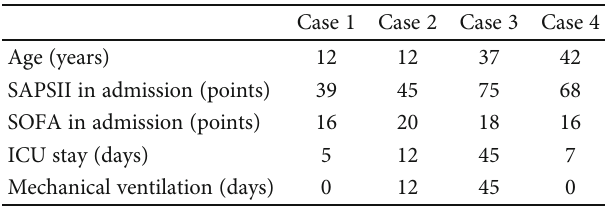
Table 1: Patients ’ characteristics.